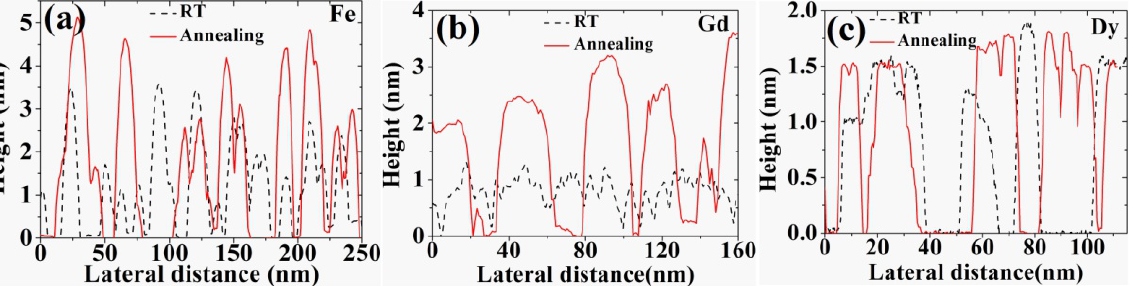
Figure 19. 1D scans along the lines shown in Figure 18 for three of the metals ( a ) Fe; ( b ) Gd; and ( c ) Dy. One line (dash black) is for RT the other (solid red) is after annealing to the higher temperature. The aspect ratio (height/width) increases with annealing which will enhance the fraction of low coordination sites and the catalytic activity with increasing temperature. Both height and width grow, but the relative height increase is larger than the relative width